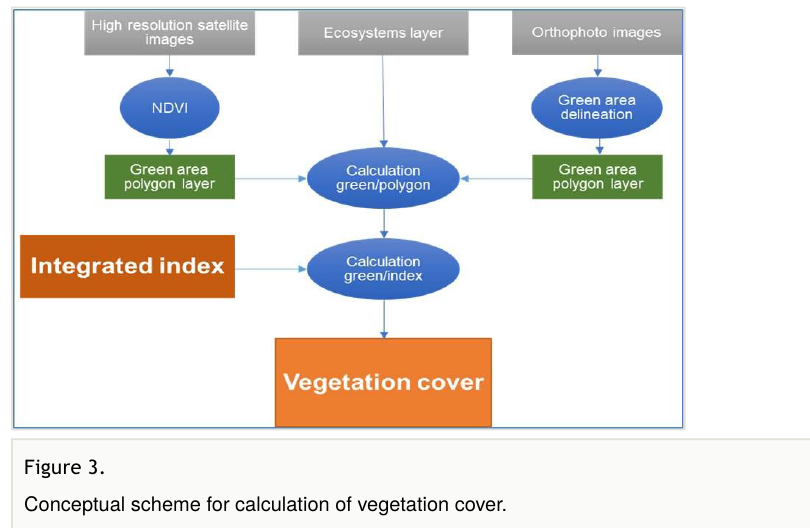
where: Asp - ecosystem condition assessment; a, b, c - urban land cover types for particular build type from Table 3; n – number of land cover types; Wlc – weighted